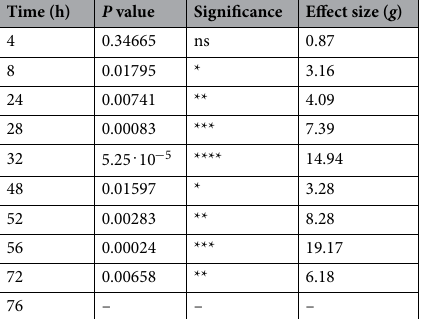
Table 1. Difference in cell survival between 2 nL and 0.5 nL drops. Statistical differences are presented as P values. Two-sided Student’s t test was used to find significance values. Effect sizes were calculated as Hedges’